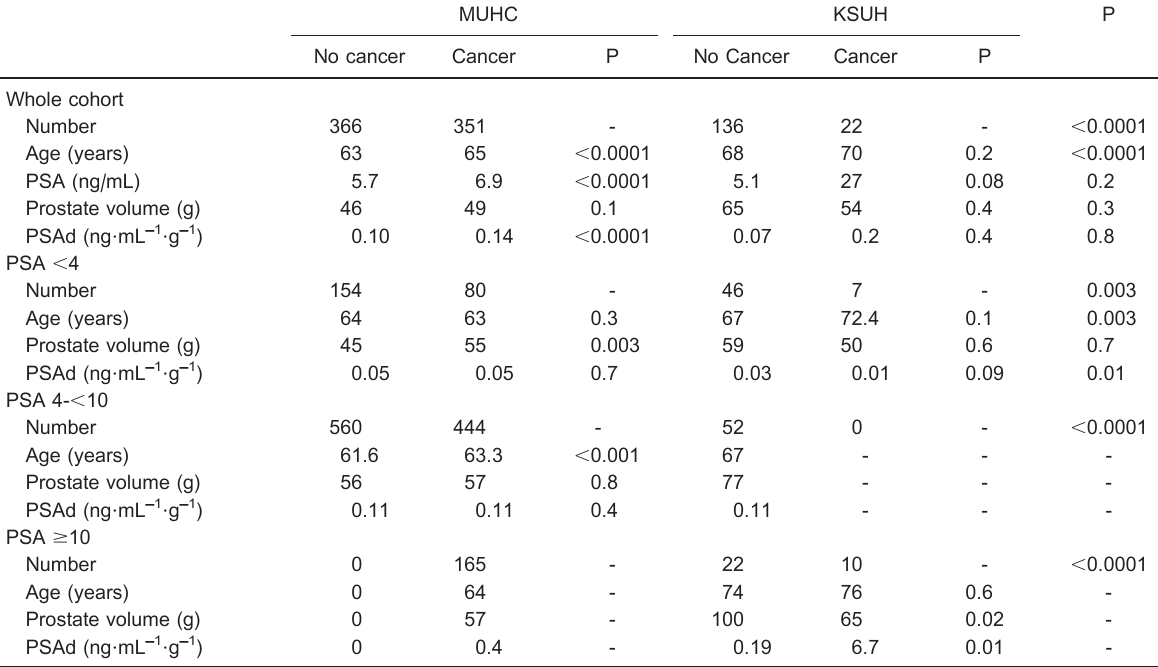
Table 4. Group characteristics with regard to the different PSA categories.